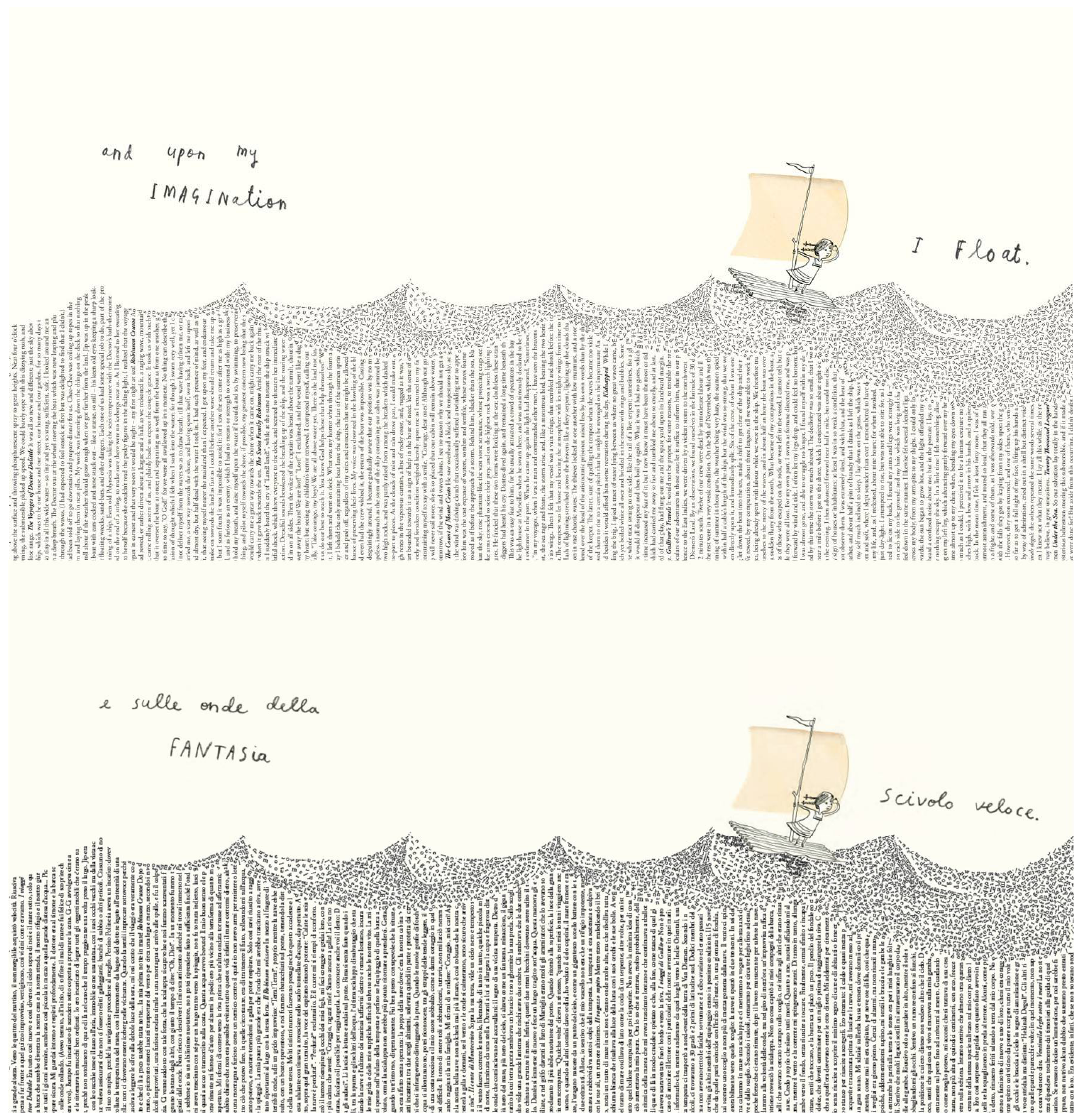
Figure A13. Jeffers O.; Winston S. A child of books, Walker Books, London, 2016; Jeffers O.; Winston S. La bambina dei libri, Lapis, Roma,